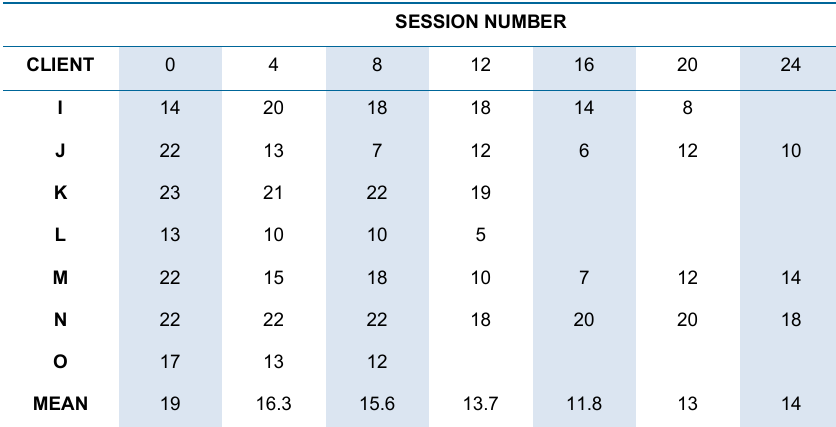
Table 8: Mean PHQ-9 score: 7 short-term clients